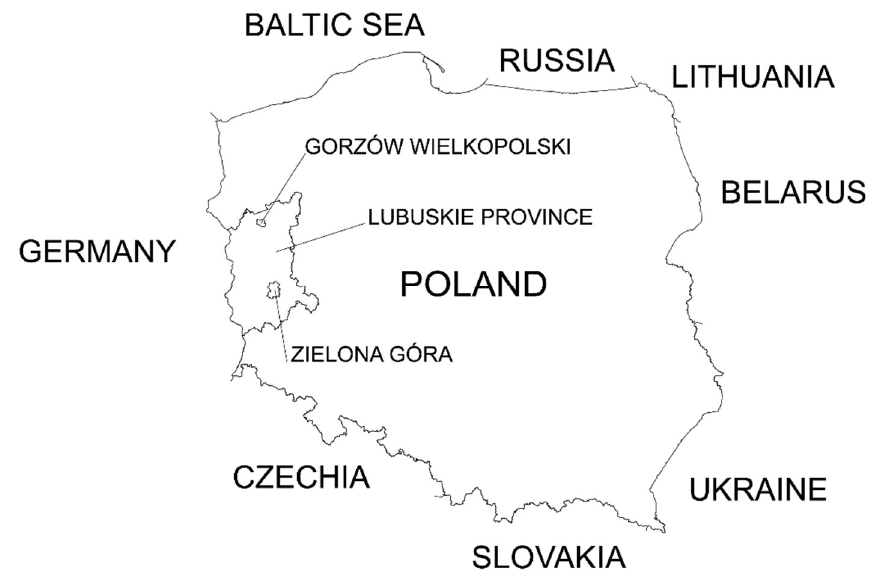
Figure 3. Location of the analysed object—Gorzów Wielkopolski (Lubuskie Province).